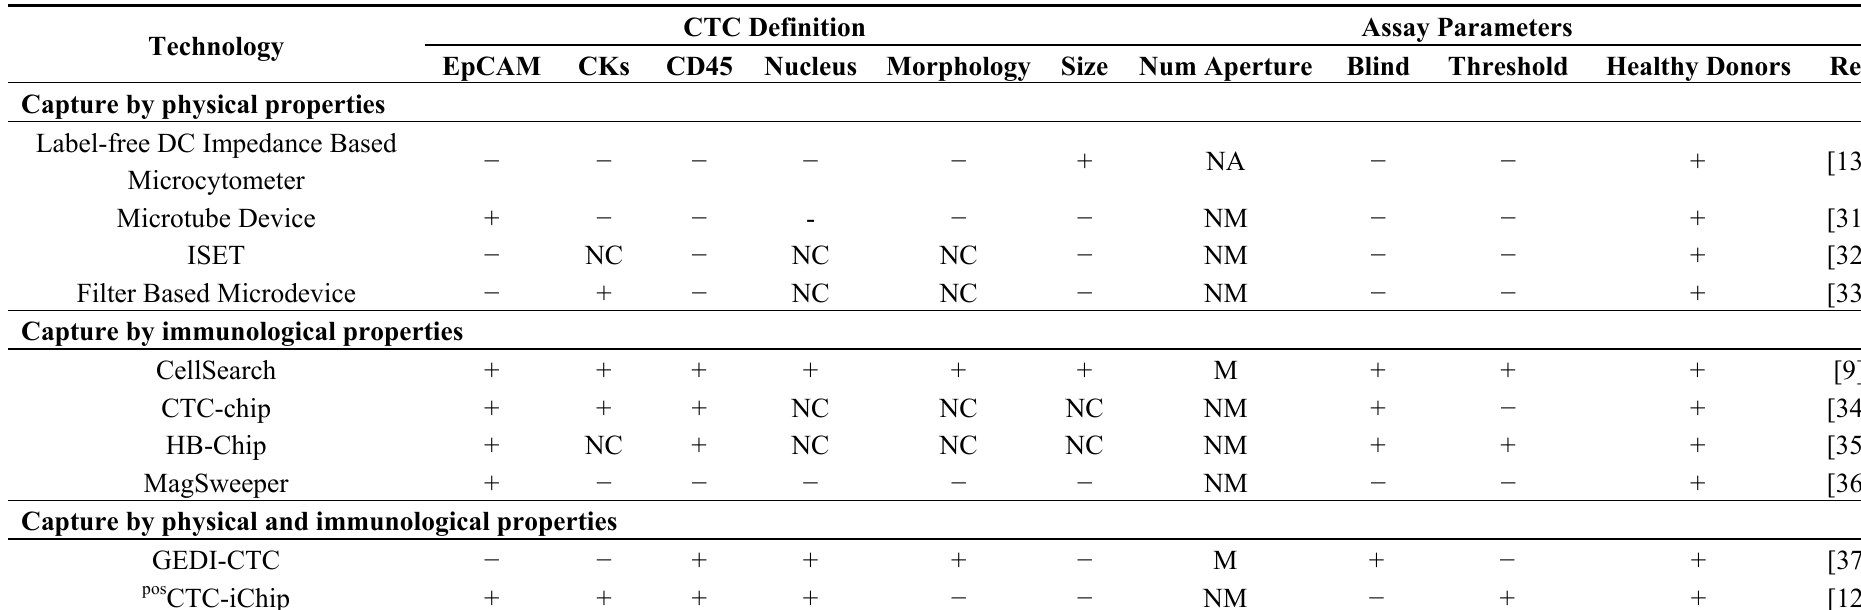
Table 1. Overview of published CTC isolation technologies comparing parameters used for CTC definition and identification. Only technologies already tested with patient samples were included. The most common parameters were compared across publications, but in some cases other parameters not specified in the table heading were considered in the original publication. For more details about each column, please see main text. As an example, the first entry of the table should read: CTC definition was size based and none of the other specified parameters were taken into account; CTC objects were not identified using images therefore numerical aperture is not an applicable parameter in this case, the assay did not include blind users and it did not include a threshold number for CTC positive